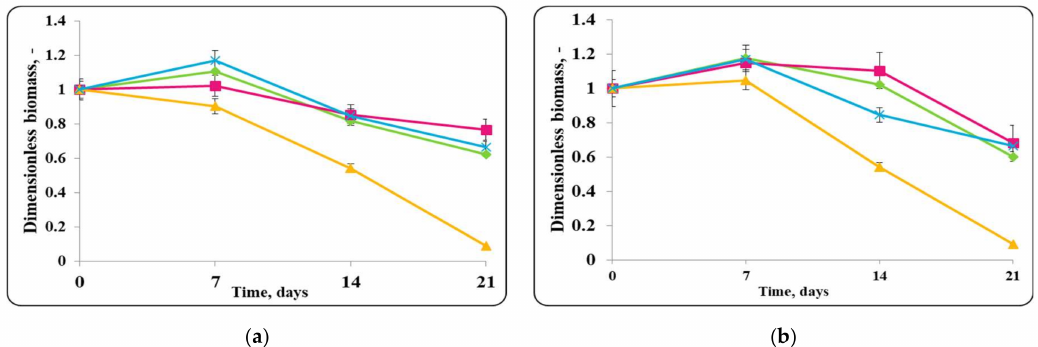
Figure 2. ( a ) free lactobacilli cells; ( b ) encapsulated lactobacilli cells. Changes in the dimensionless biomass of Lb. helveticus 2/20 and E. coli ATCC 25922 in chocolate mousse at 4 ± 2 ◦ C. Legend: Green (cid:117) : Lb. helveticus 2/20 population following its inoculation; Pink (cid:4) : Lb. helveticus 2/20 population following its co-inoculation with E. coli ATCC 25922; Blue × : E. coli ATCC 25922 population following its direct inoculation; Yellow (cid:78) : E. coli ATCC 25922 population following its co-inoculation with Lb. helveticus